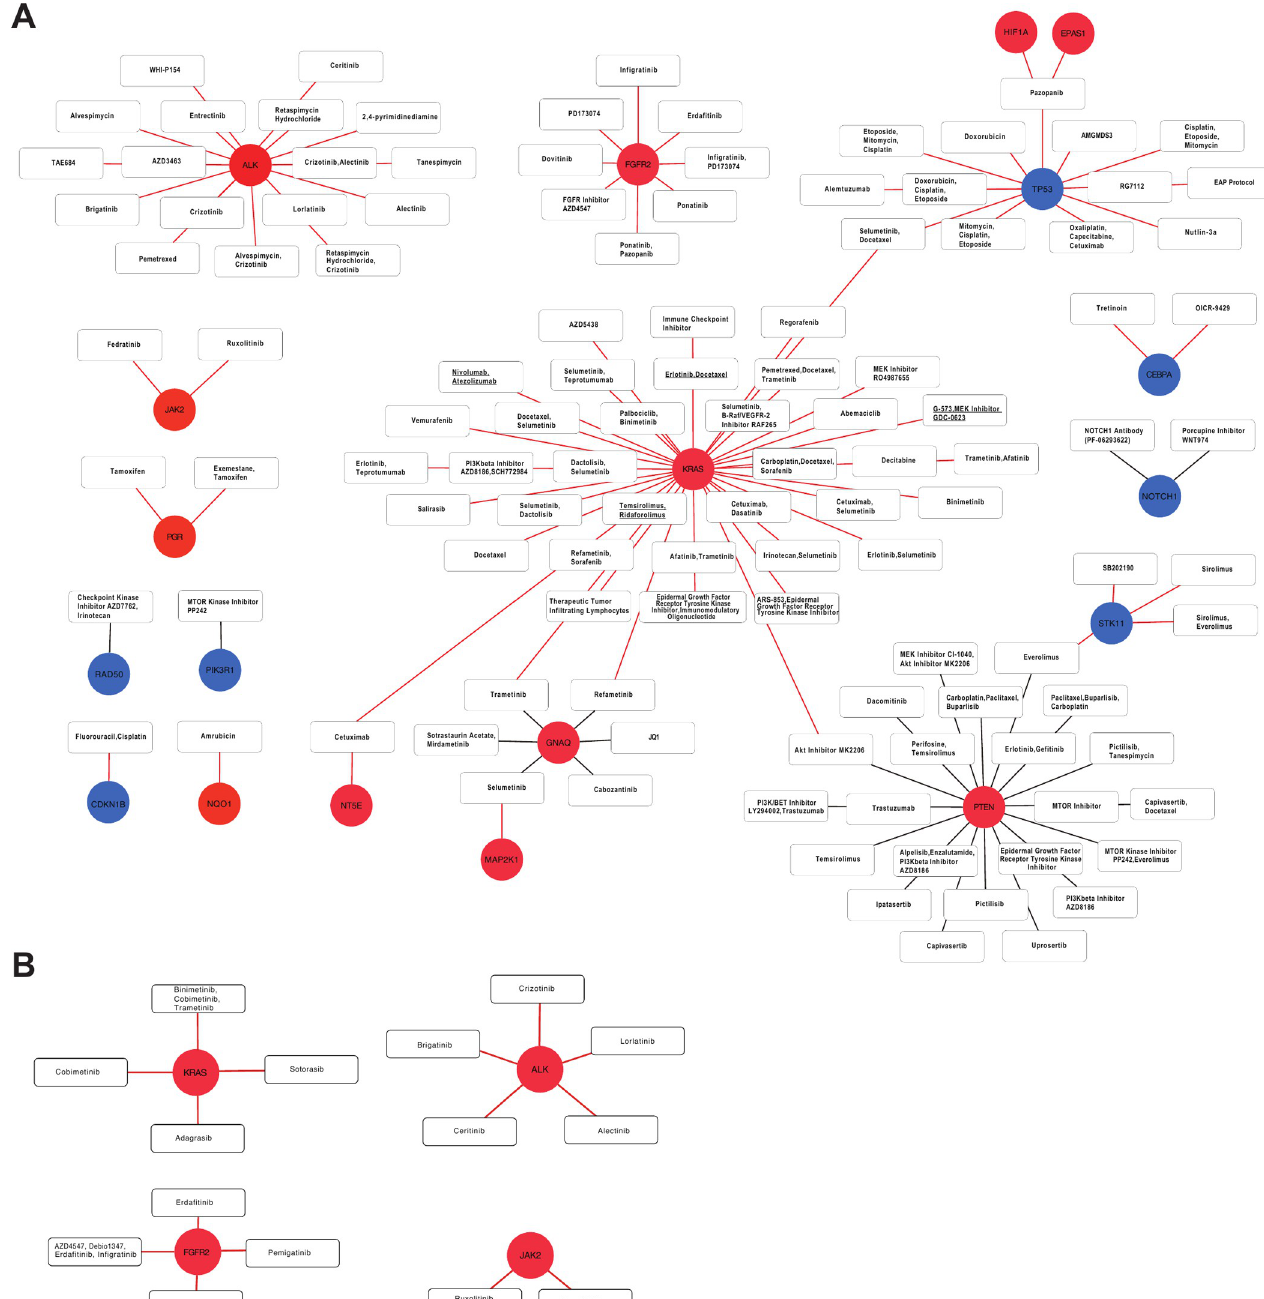
Fig 3. Inferred drug-target network in PTPRK-RSPO3 fusion-positive colorectal cancer. Drug-target relation was obtained based on CIViC and OncoKB databases: White boxes, drugs; circles, underlined white boxes, substitute drugs; genes; red circles, genes that are over-expressed in fusion-positive cancer; blue circles, genes that are under-expressed in fusion-positive cancer. The red lines are prioritized drug-target relationships based on the scenario that properly working cancer drugs are generally inhibitors for activated oncogenes or activators for down-regulated tumor suppressor genes.